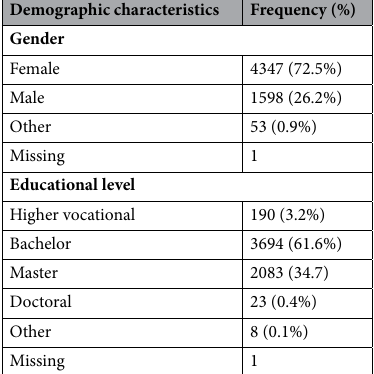
Table 1. Demographic properties of the sample (N =